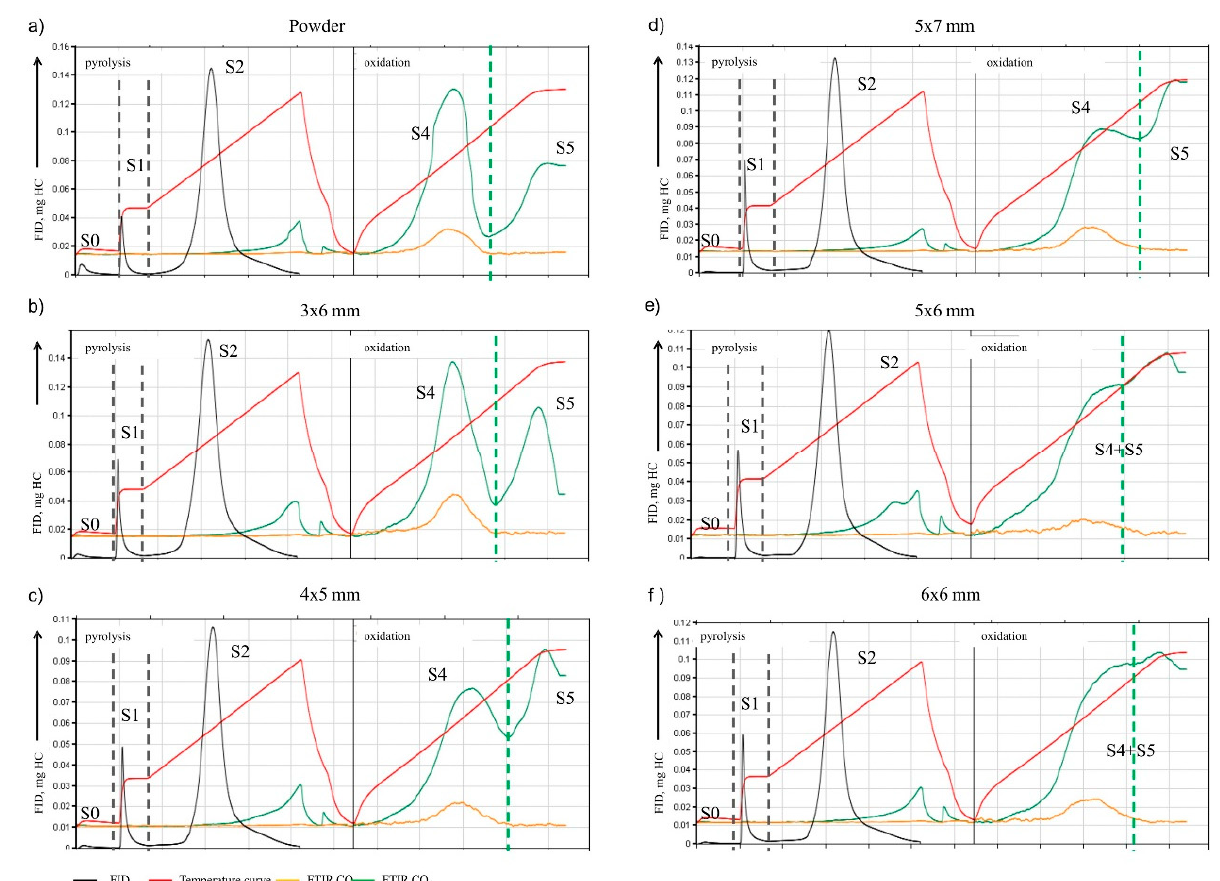
Figure 6. Examples of pyrogram for a sample (lithotype D4) with different S4–S5 shape ( a ) specimen in the form of powder, ( b – f ) specimen in the form of fragments of various size.